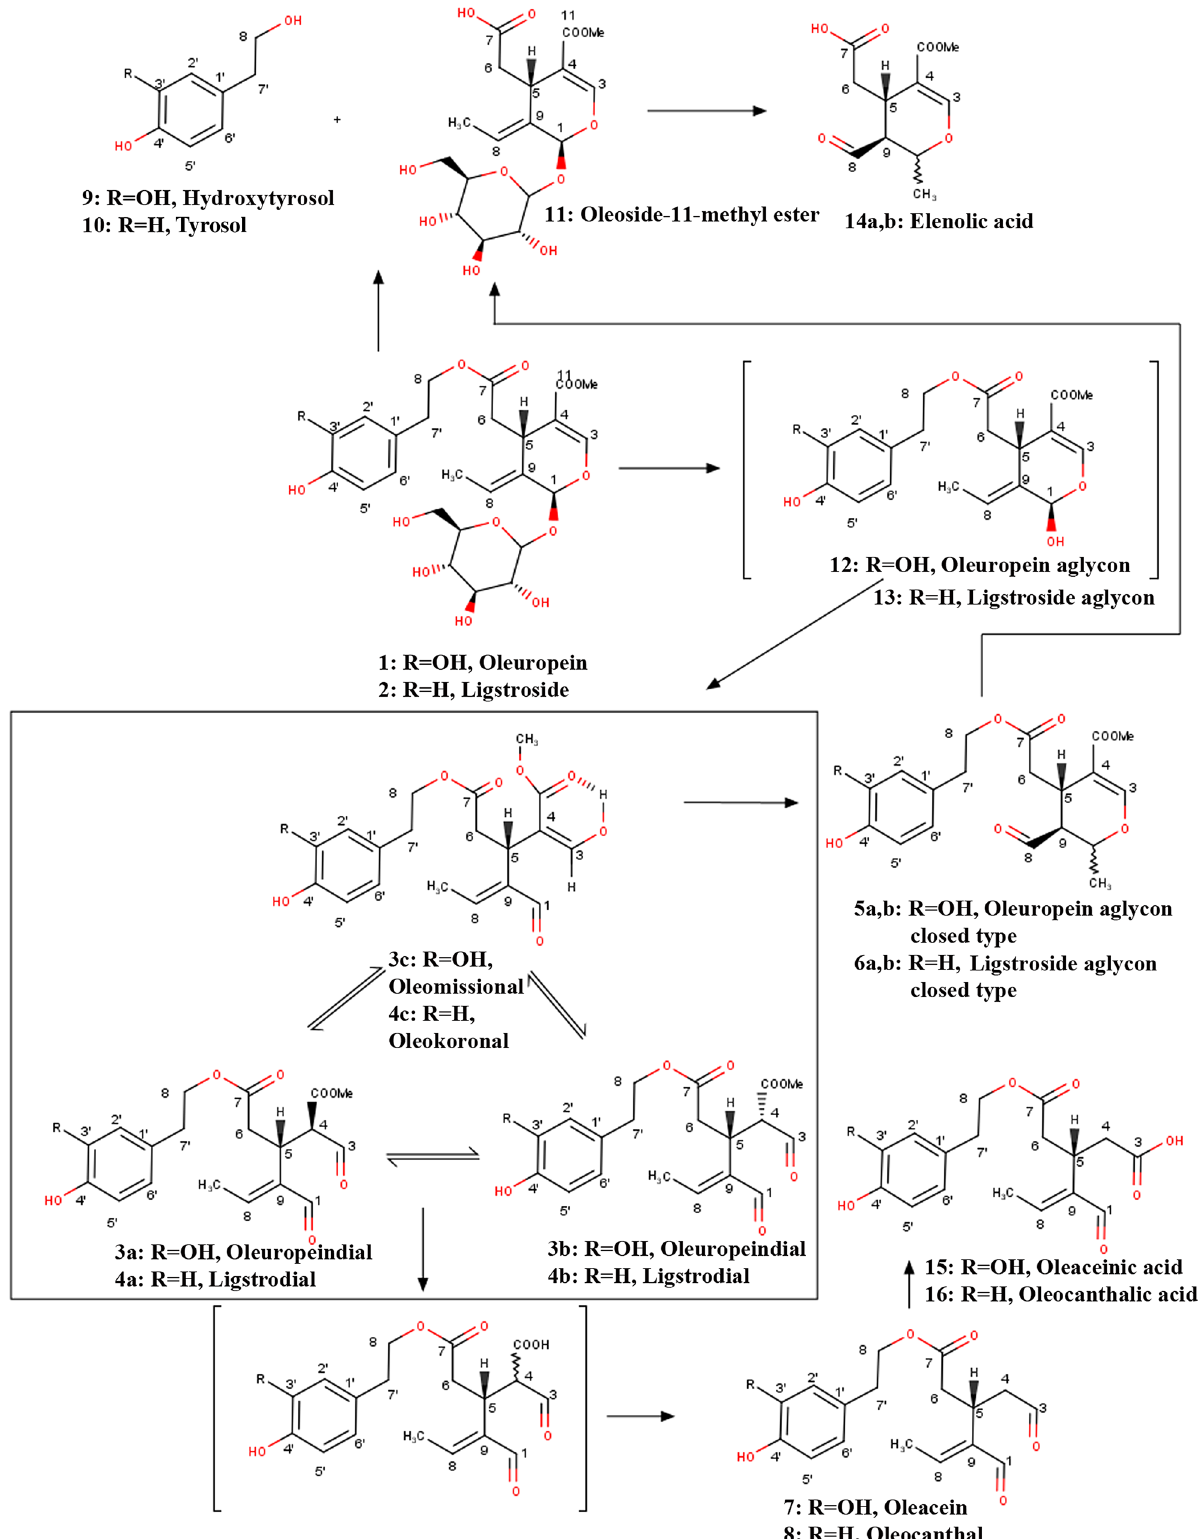
Figure 1. The structures of the studied phenolic compounds from olives and olive oil and their biosynthetic relationships. Oleuropein (1), ligstroside (2), oleuropeindial (3a,b), oleomissional (3c), ligstrodial (4a,b), oleokoronal (4c), oleuropein aglycon closed type (5a,b), ligstroside aglycon closed type (6a,b), oleacein (7), oleocanthal (8), hydroxytyrosol (9), tyrosol (10), oleoside-11-methyl ester (11), oleuropein aglycon (unstable form) (12), ligstroside aglycon (unstable form) (13), elenolic acid (14a,b), oleaceinic acid (15), oleocanthalic acid (16). a,b correspond to the two possible stereoisomers of the